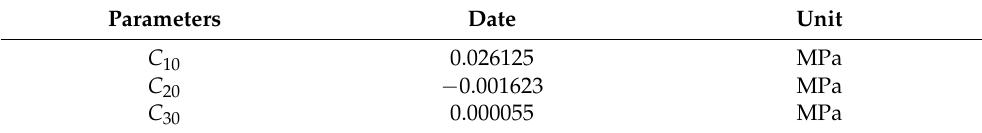
Table 3. Uniaxial Yeoh model parameters.